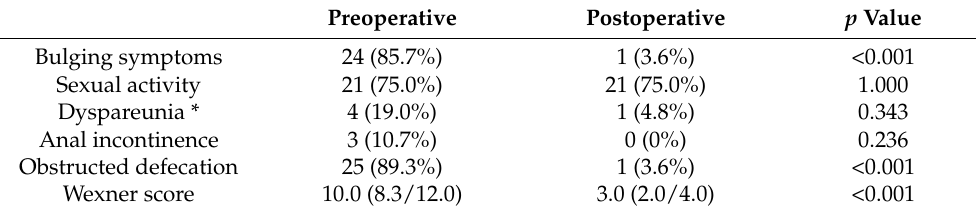
Table 4. Functional outcomes. Data as absolute (relative) frequencies for categorical variables and median (interquartile range) for continuous ones. * only for sexually active